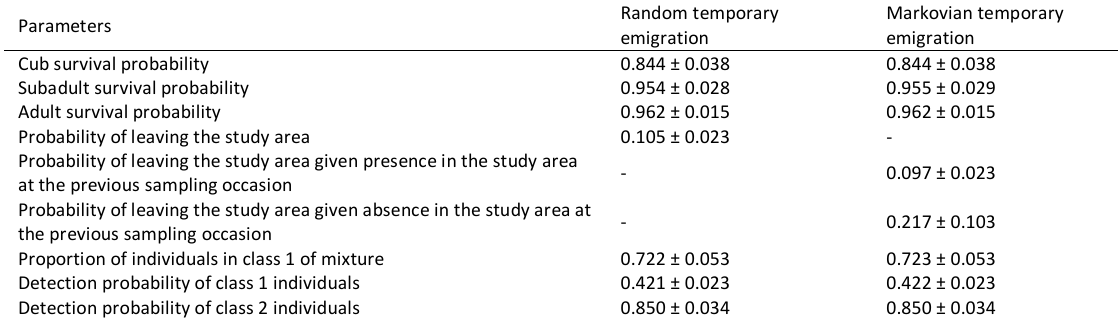
Table 2: Parameter estimates (estimates ± SE) for the two best-supported models from the frequentist capture-recapture (CR) approach (see models 1 and 2 from Table 1) using a robust design, in which temporary emigration is either random (first column) or Markovian (second